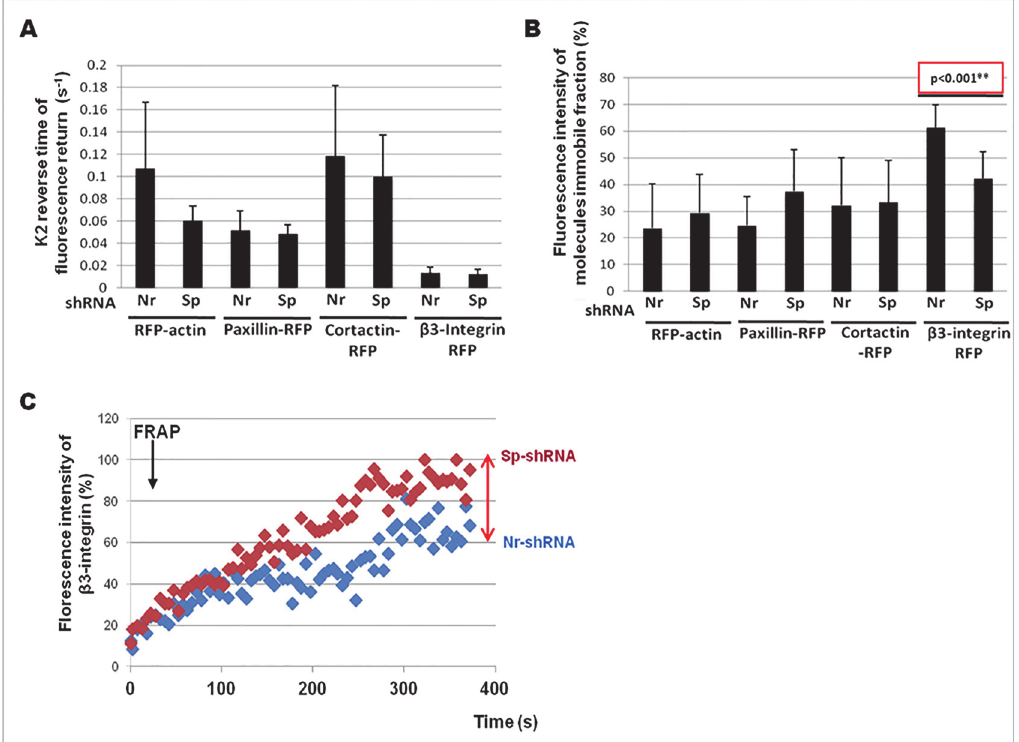
Fig 8. Deficiency of α II-spectrin increases the mobile fraction of β 3-integrin in invadosome rings. SrcY527F_MEF cells were transfected for 72 hr with irrelevant shRNA (Nr-shRNA) or shRNA targeting α II-spectrin (Sp-shRNA) along with RFP-actin, paxillin-RFP, RFP-cortactin or β 3-integrin RFP plasmids in order to quantify the mobility of these invadosome components (by FRAP) in presence or absence of α II-spectrin. (A) A simple exponential equation model was used to quantify K2 (in sec -1 ), which is the inverse of the characteristic time of fluorescence recovery (tau), in order to evaluate the diffusion speed of these invadosome proteins. No significant changes were observed, indicating that α II-spectrin does not affect the net rate of entry of these components in invadosomes. (B) Quantification of the immobile fraction of each of these invadosome components. Immobile fraction of actin, paxillin and cortactin remained constant between control and spectrin-depleted cells. However, α II-spectrin depletion significantly reduced the immobile fraction of β 3-integrin in invadosomes. (C) Representative FRAP recovery curves of β 3-integrin-RFP in presence (Nr-shRNA) or absence (Sp-shRNA) of α II-spectrin. In absence of α II-spectrin, the number of immobile β 3-integrin molecules is more important while the plateau is smaller than in presence of α II-spectrin. Results for quantification were obtained from 3 independent experiments where 10 to 11 cells were analyzed for each